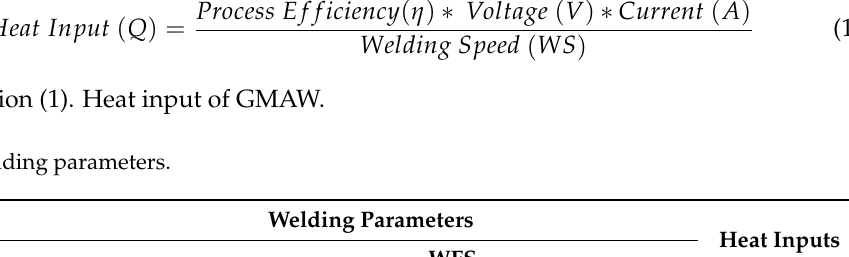
Figure 3. A schematic showing cross sections for the 30 and 50% overlapping beads. Table 2. Welding parameters.